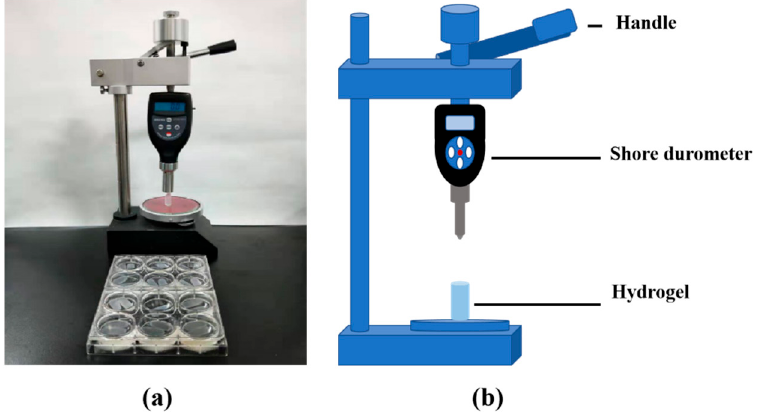
Figure 12. Schemical description of the hardness testing equipment ( a ) and measurement mechanism ( b